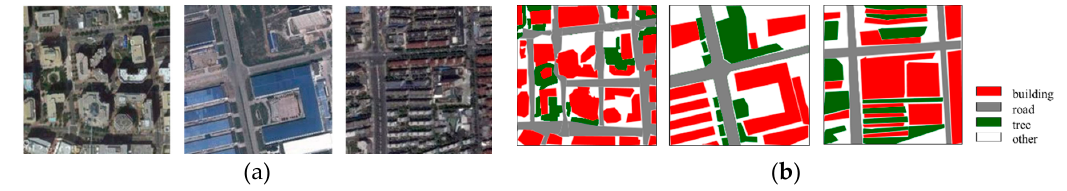
Figure 6. Google dataset and Synthetic dataset: ( a ) Google dataset (from left to right: commercial, industrial, and residential area); and ( b ) synthetic dataset (from left to right: commercial, industrial, and residential area).